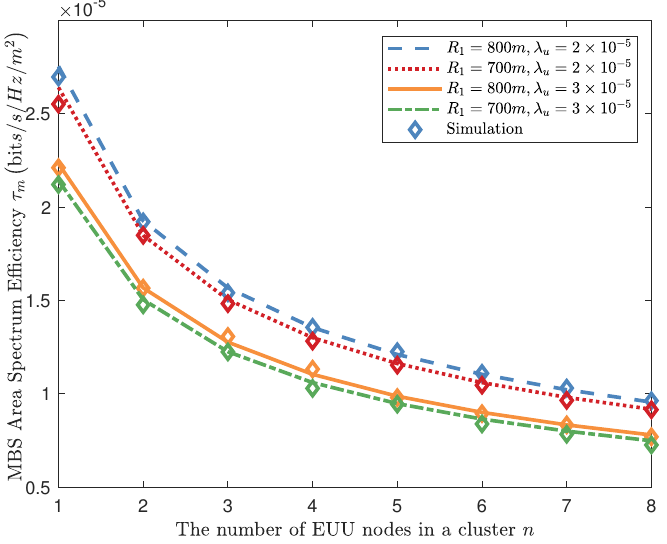
Figure 6. The relation between area spectrum efficiency of the MBS, τ m , and the number of EUUs within a cluster, n , with different cluster radius a ; SINR threshold is γ m = 5 dB; the transmit power of EUUs is 10